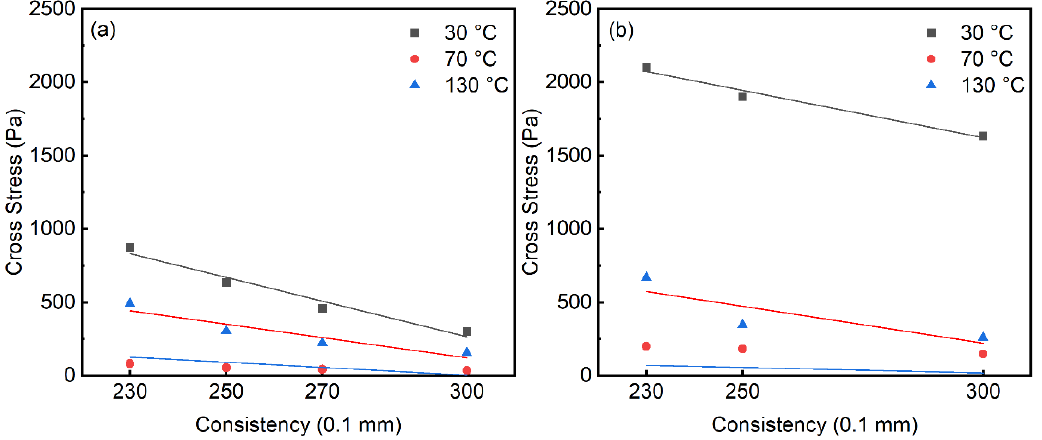
Figure 9. Cross-stress τ co of greases with different consistencies at different temperatures: ( a ) lithium grease, ( b ) polyurea grease.